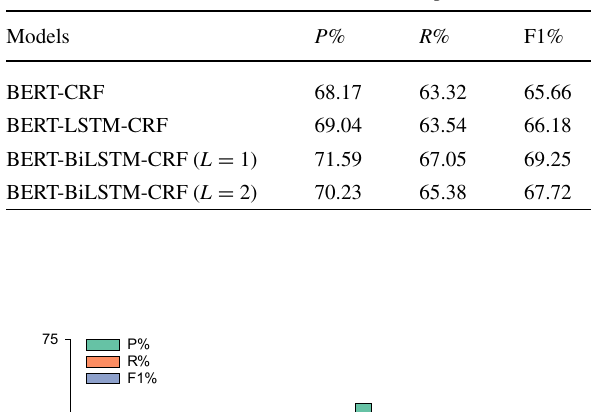
Table 5 Contribution of context features to model performance